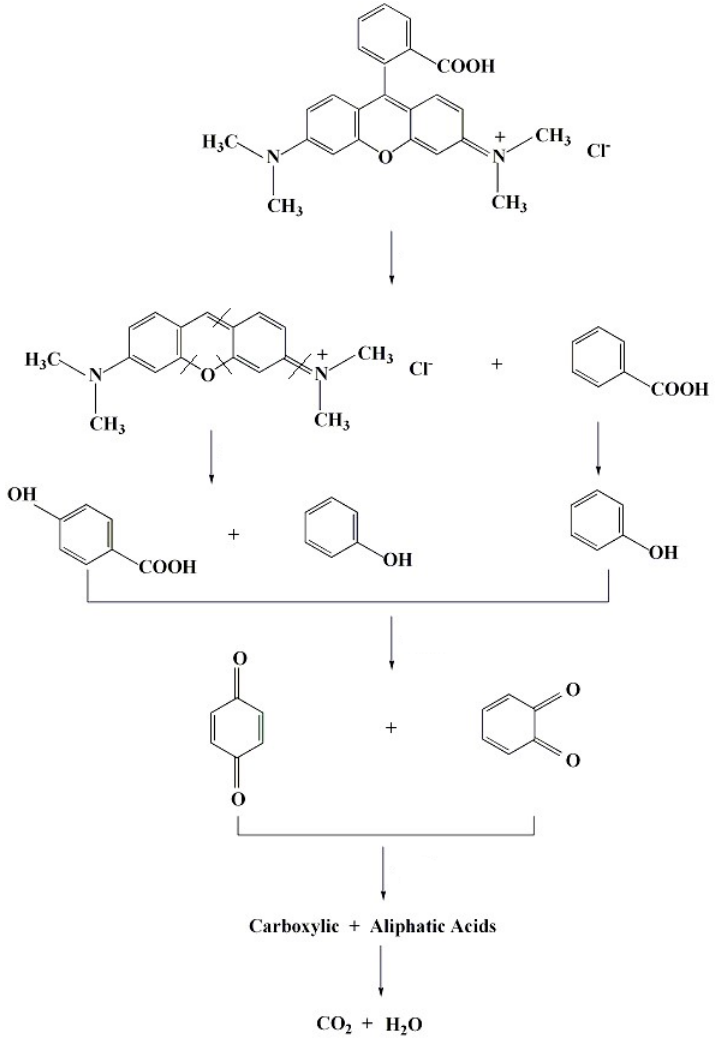
Figure 11. The degradation pathways for RhB.